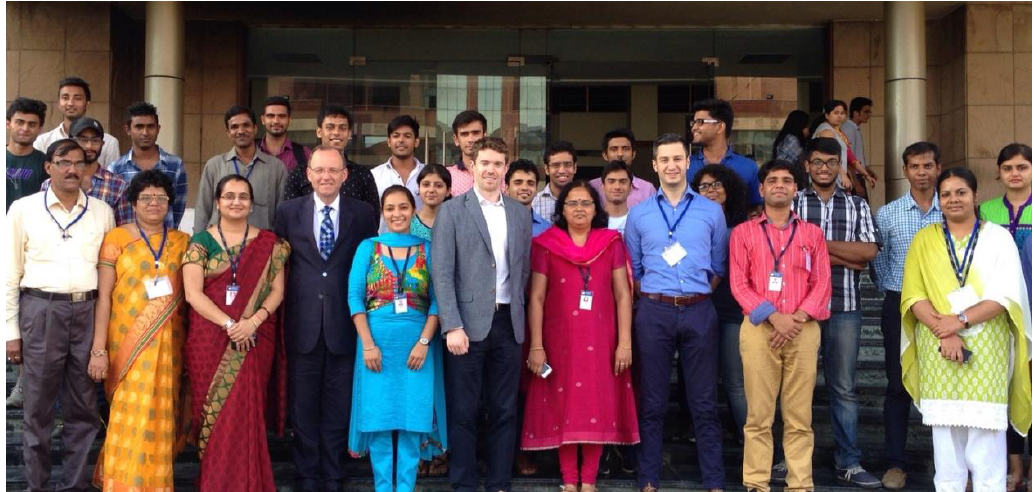
Figure 2. Delegates and participants in the second week of the PDC held from August 24-28, 2015,